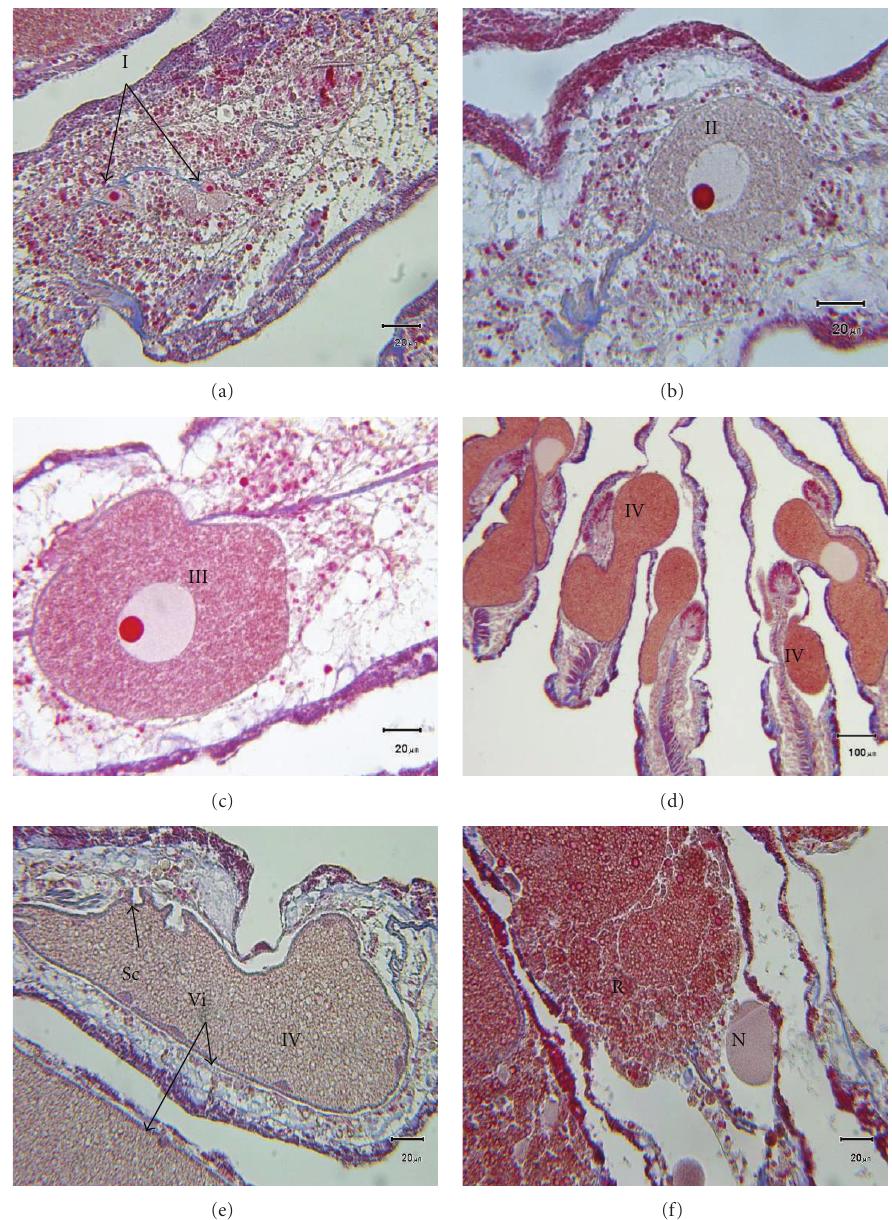
Figure 10: Photomicrographs of Stephanocoenia intersepta oocyte stages I–IV (defined by Table 1). (a) Stage I oocytes; (b) stage II oocyte; (c) stage III oocyte; (d) stage IV oocytes; (e) stage IV oocyte, Vi = vitelline membrane, Sc = scalloping of vitilline membrane; (f) oocyte resorption (R), N = Nucleus. All scale bars 20 μ m except (d) which is 100 μ